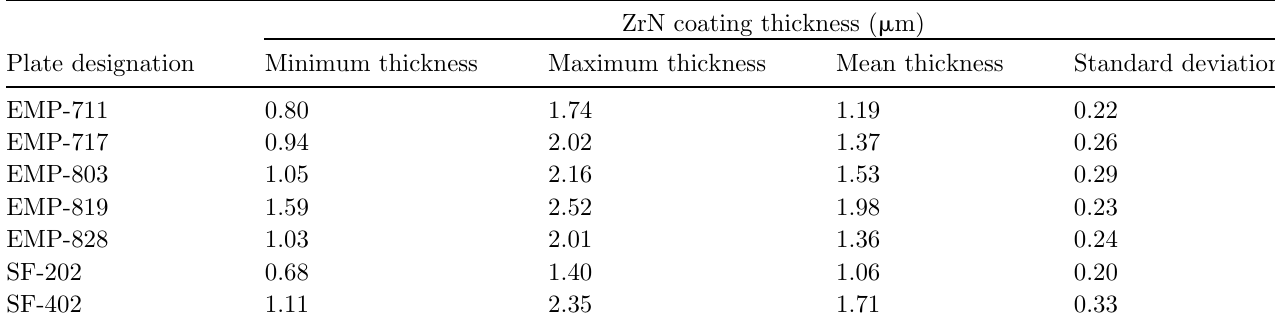
Fig. 7. SEM micrographs taken on: (a) a PVD-coated powder from one EMPIrE batch, (b) SF-202 plate, (c) EMP-819 plate, (d) EMP-828 plate (white arrow: rolling direction (cid:3) dashed line: approximate position of fuel-cladding interface). Table 3. ZrN coating thickness